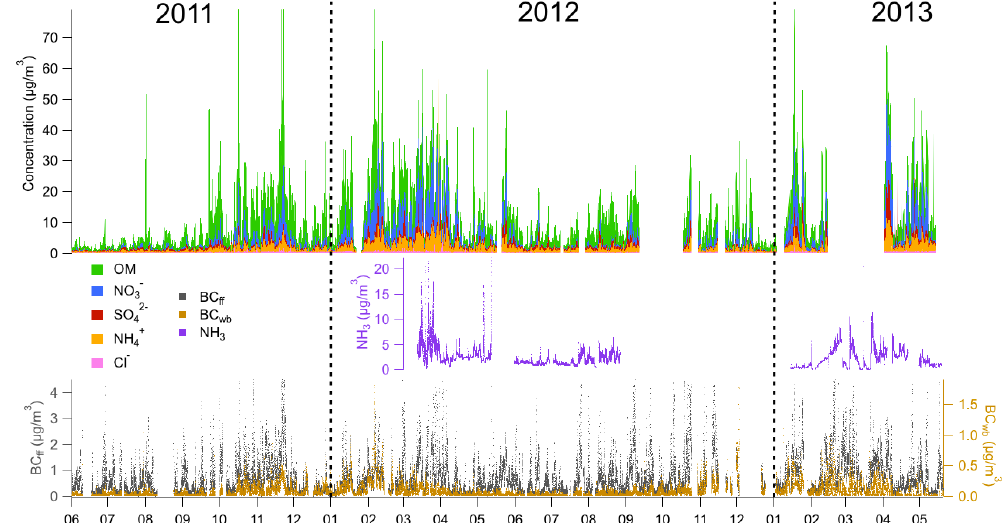
Figure 1. Time series of the major 30min non-refractory (top, concentrations are aggregated) and 5min refractory (bottom, concentrations are dissociated) PM 1 chemical constituents, and 5min ammonia at SIRTA from June 2011 to May 2013. The two large data gaps in October 2012 and March 2013 correspond to two field intensive campaigns during which the ACSM was deployed